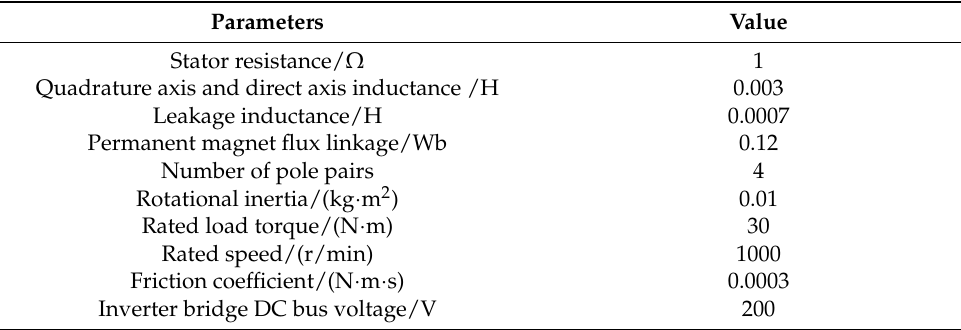
Table 1. Parameters of the motor and drive system.